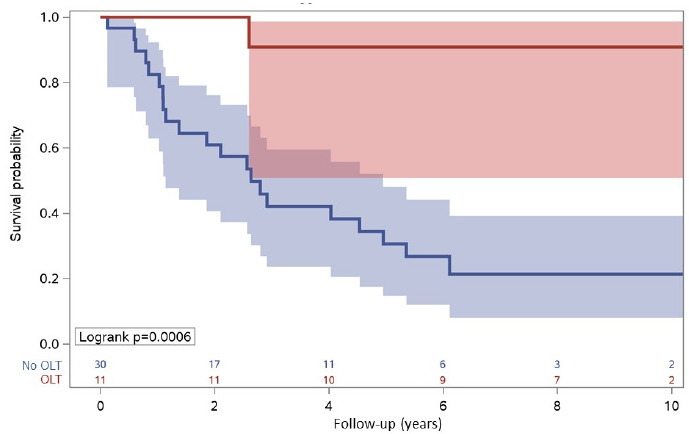
Figure 3. Survival according to OLT or other invasive therapy including LR, RFTA, CRE.